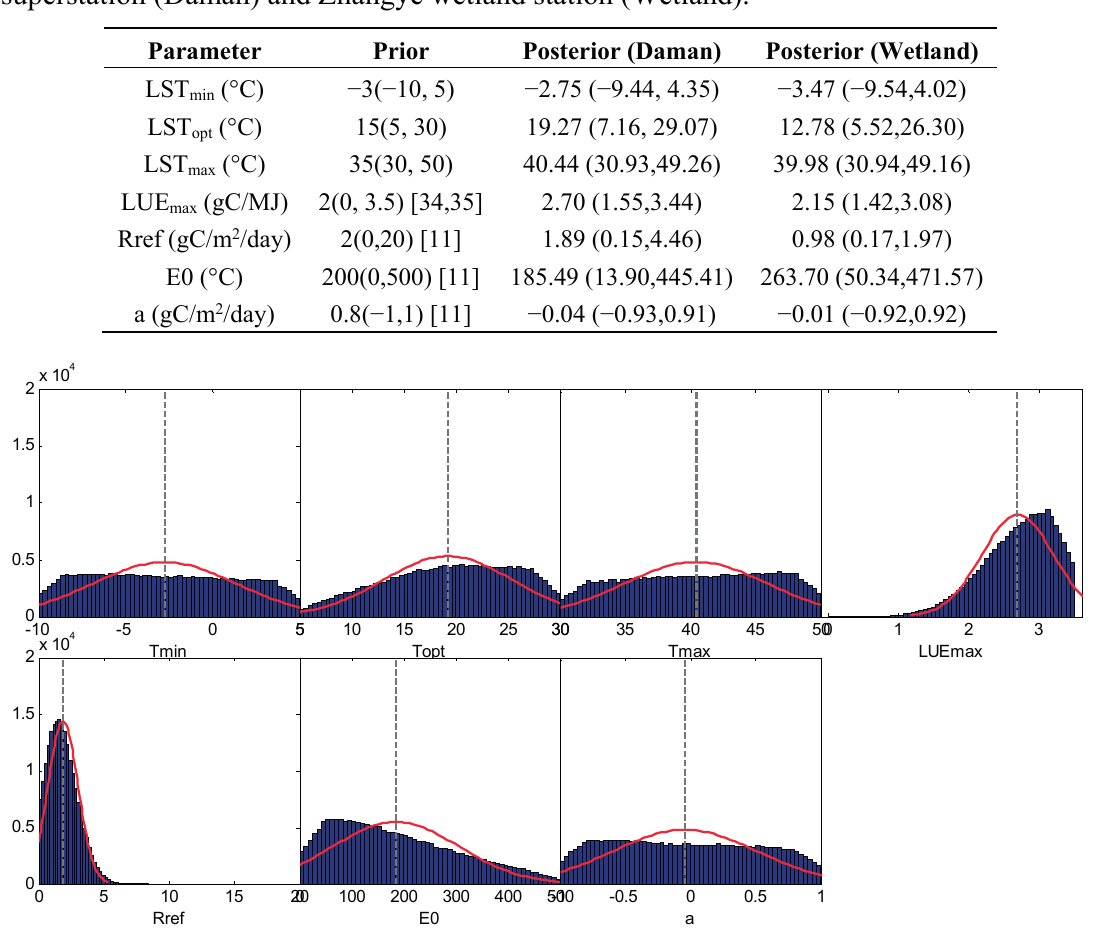
Figure 4. Histograms of the RS-CFLUX model parameters at the Daman superstation (maize).